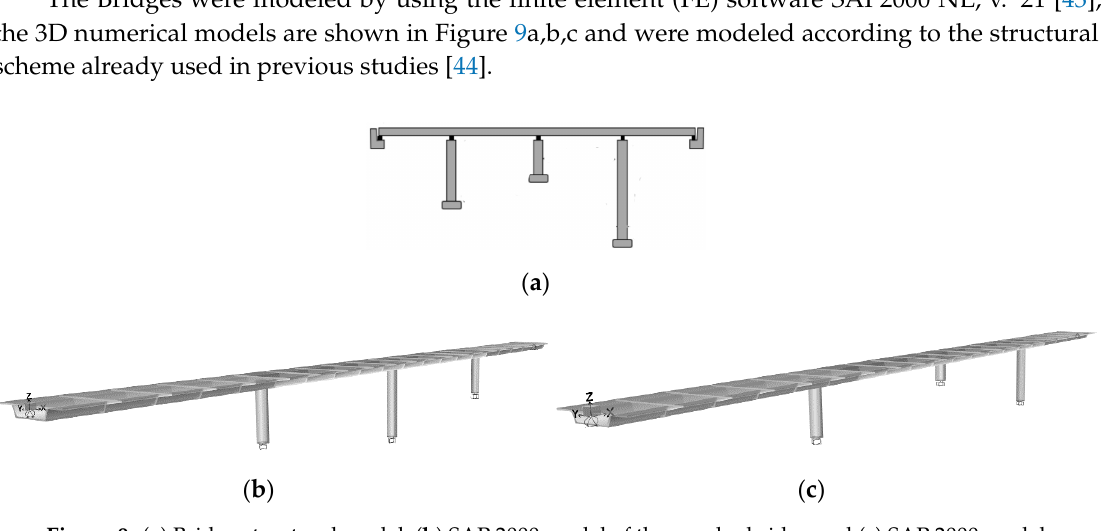
Figure 9. ( a ) Bridge structural model, ( b ) SAP 2000 model of the regular bridge and ( c ) SAP 2000 model of the irregular bridge.